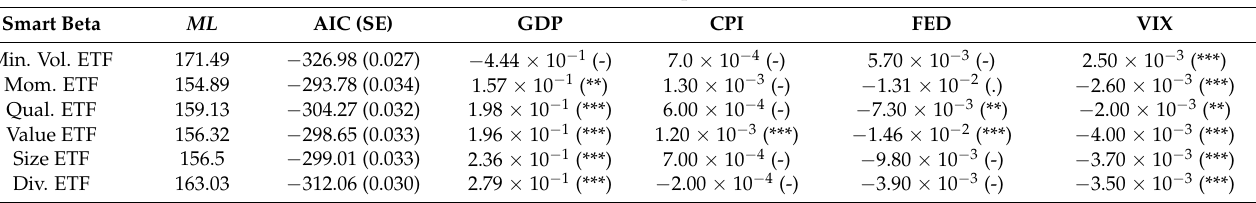
Table A4. Results of model (A1)–(A2) (Panels A and B) applied to smart beta and financial ETF portfolios. Panel A includes data